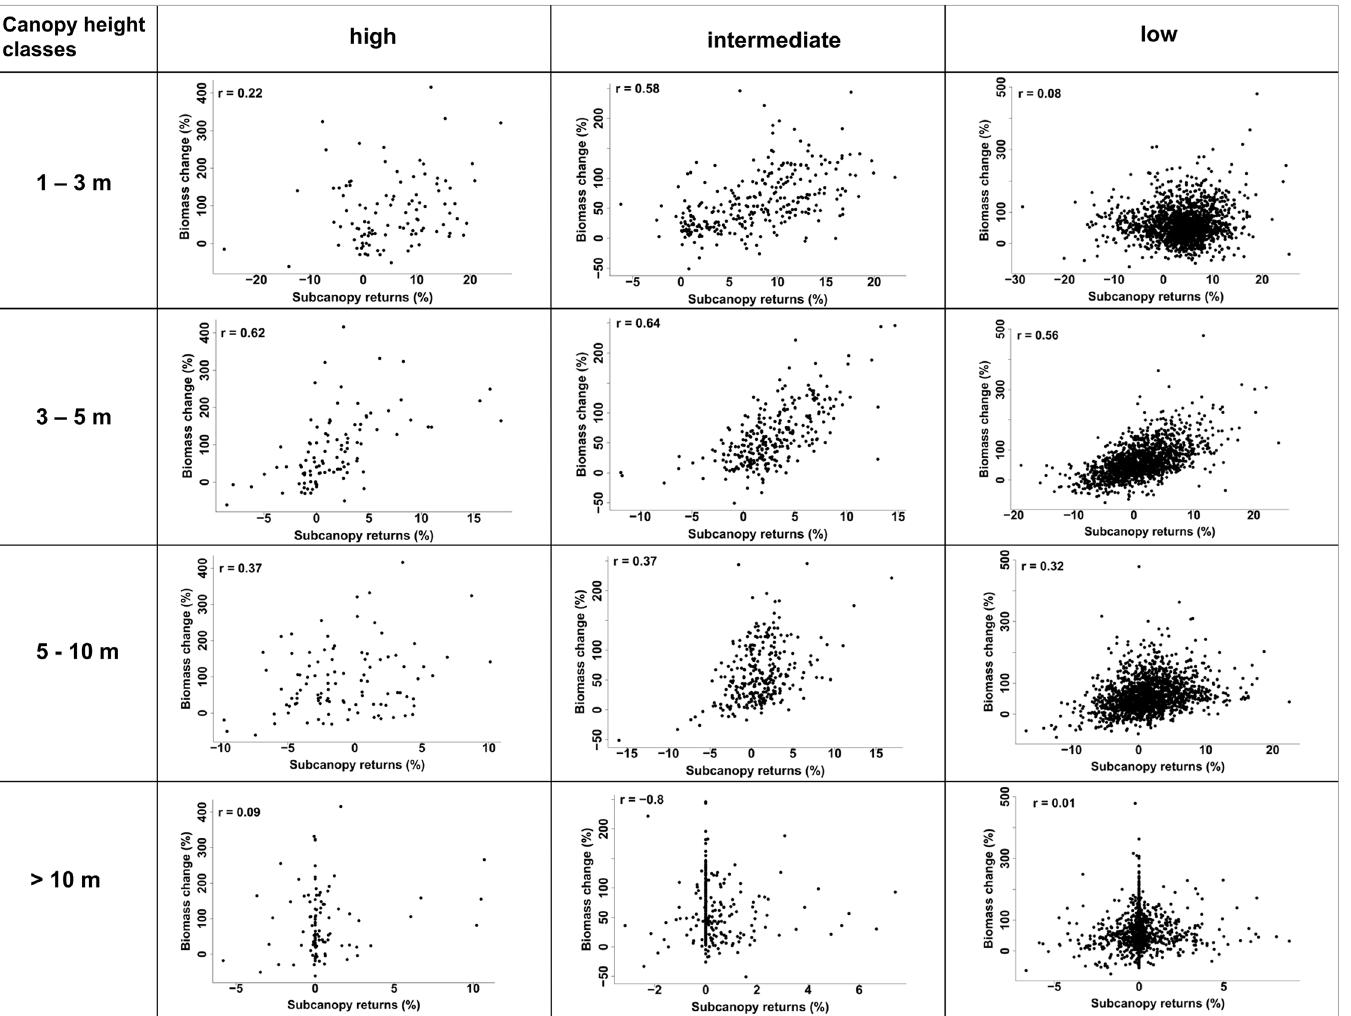
Fig 5. Height-specific correlation (p < 0.001) between change in biomass (%) and subcanopy returns (%). Wood extraction levels for each rangeland are listed per column as high, intermediate and